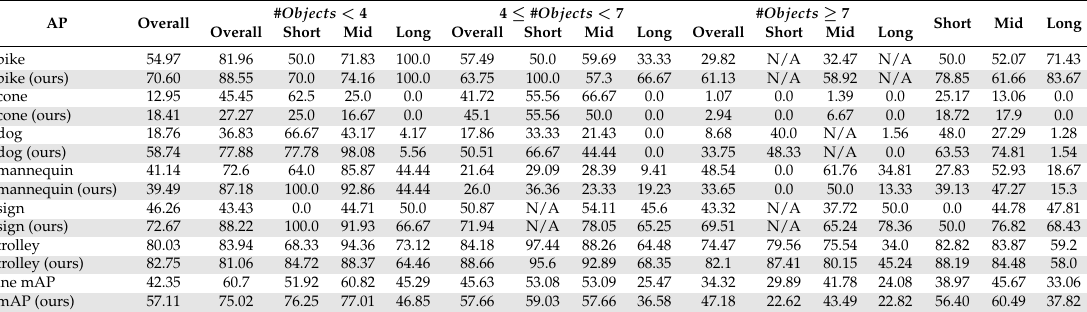
Table 7. Constant false alarm rate detection and DBSCAN clustering followed by neural network